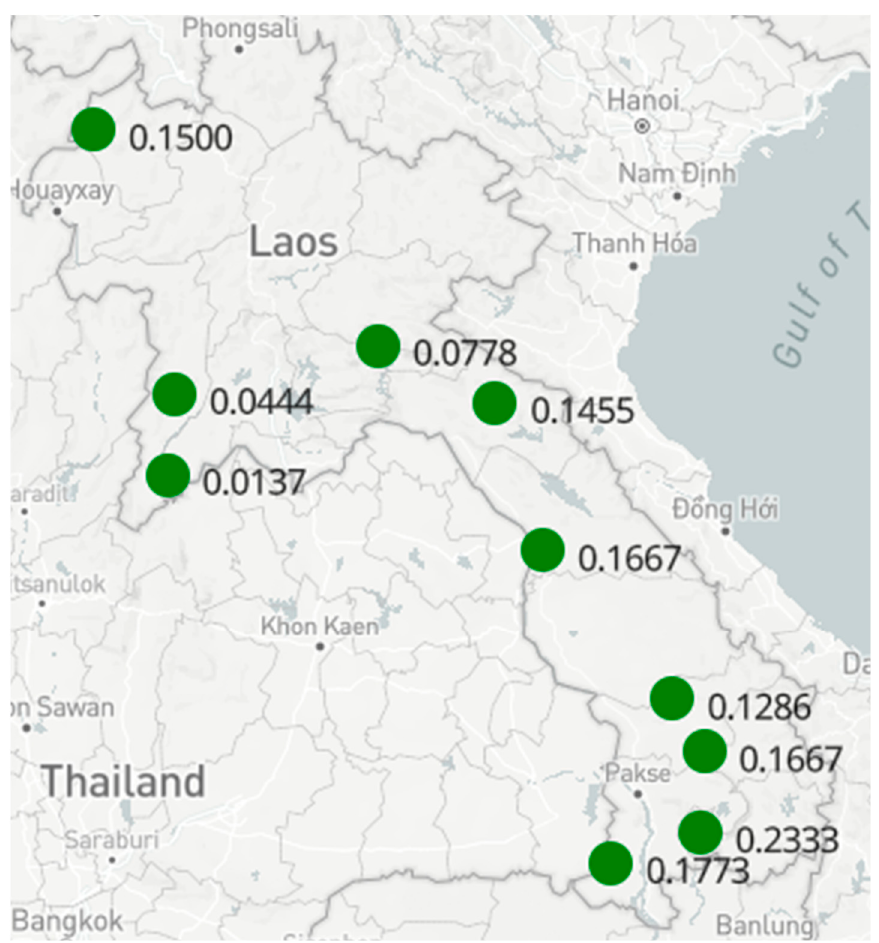
Figure 2. Map of Lao PDR showing abundance of cassava whiteflies per surveyed province. https://pdptest.ciat.cgiar.org/projects/PDP_00088/map?provinces-4.79/15.34/98.13. Accessed on 15 of March 2021.